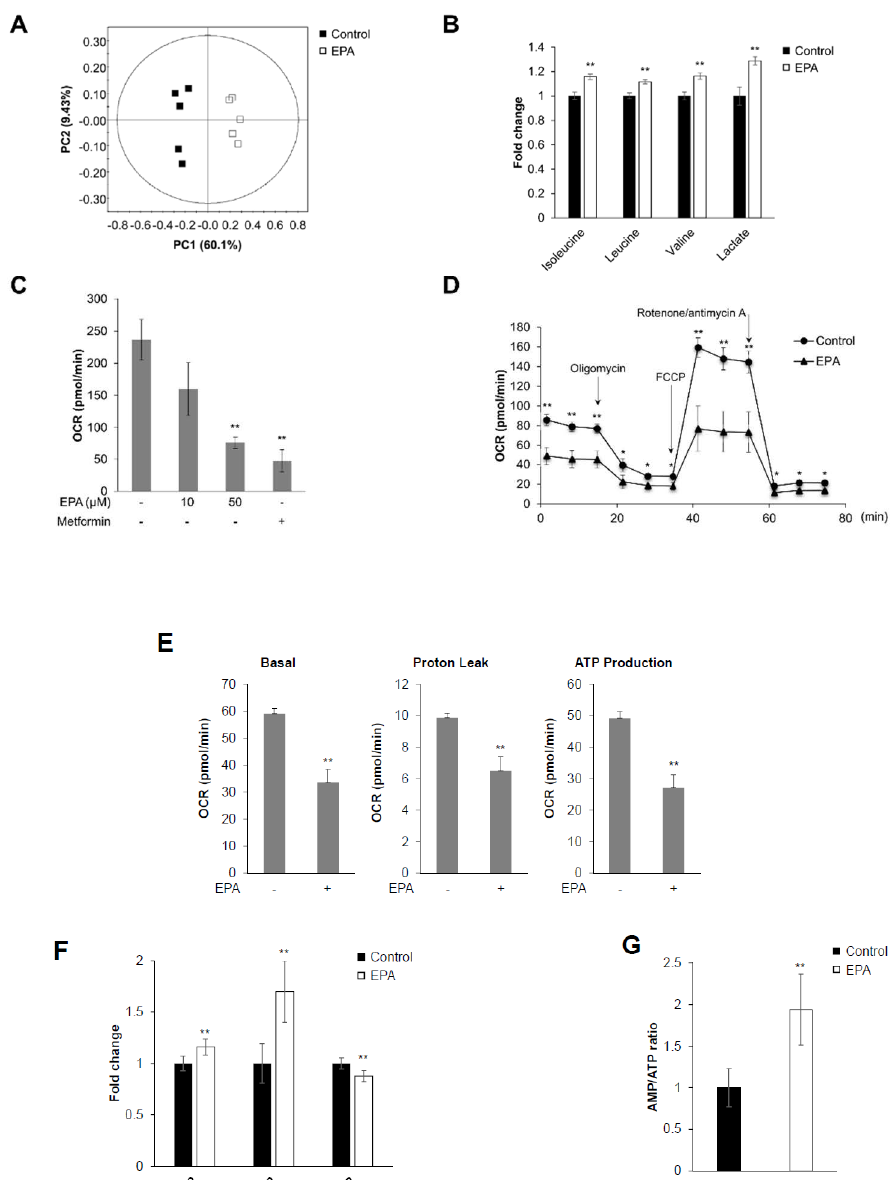
Figure 1. EPA inhibits mitochondrial oxygen consumption rate (OCR) and decreases intracellular AMP:ATP ratio in skeletal muscle cells. C2C12 cells were stimulated with 50 µ M EPA for 3 h. Cellular metabolites were extracted with MeOH / water / CHCl 3 , and NMR-based metabolic profiling was conducted. ( A ) PCA score plot for 1 H-NMR spectra of cellular metabolite extract levels for metabolome analysis. ( B ) Levels of BCAAs (isoleucine, leucine, and valine), lactate, fumarate, and malate in C2C12 cellular metabolite extracts. ( C ) C2C12 cells treated with the indicated dose of EPA and 10 mM metformin for 18 h, respectively. Mitochondrial oxygen consumption rate (OCR) measured using an XF24 analyzer. Metformin was used as a positive control. ( D ) Mitochondrial OCR in EPA (50 µ M) stimulated cells measured using an XFp analyzer in response to 1 µ M oligomycin, 0.5 µ M FCCP, and 0.5 µ M rotenone / antimycin A. ( E ) Basal respiration, proton leak, ATP production calculated from (D). ( F ) 1 H-NMR-based metabolic profiling analysis showing the intensity of the adenosine phosphates ATP, ADP, and AMP in EPA-treated or untreated cellular metabolite extracts. ( G ) AMP:ATP ratio derived from 1 H-NMR spectral intensities. * p < 0.05, ** p < 0.01 compared to untreated cells. Results from three independently replicated experiments are